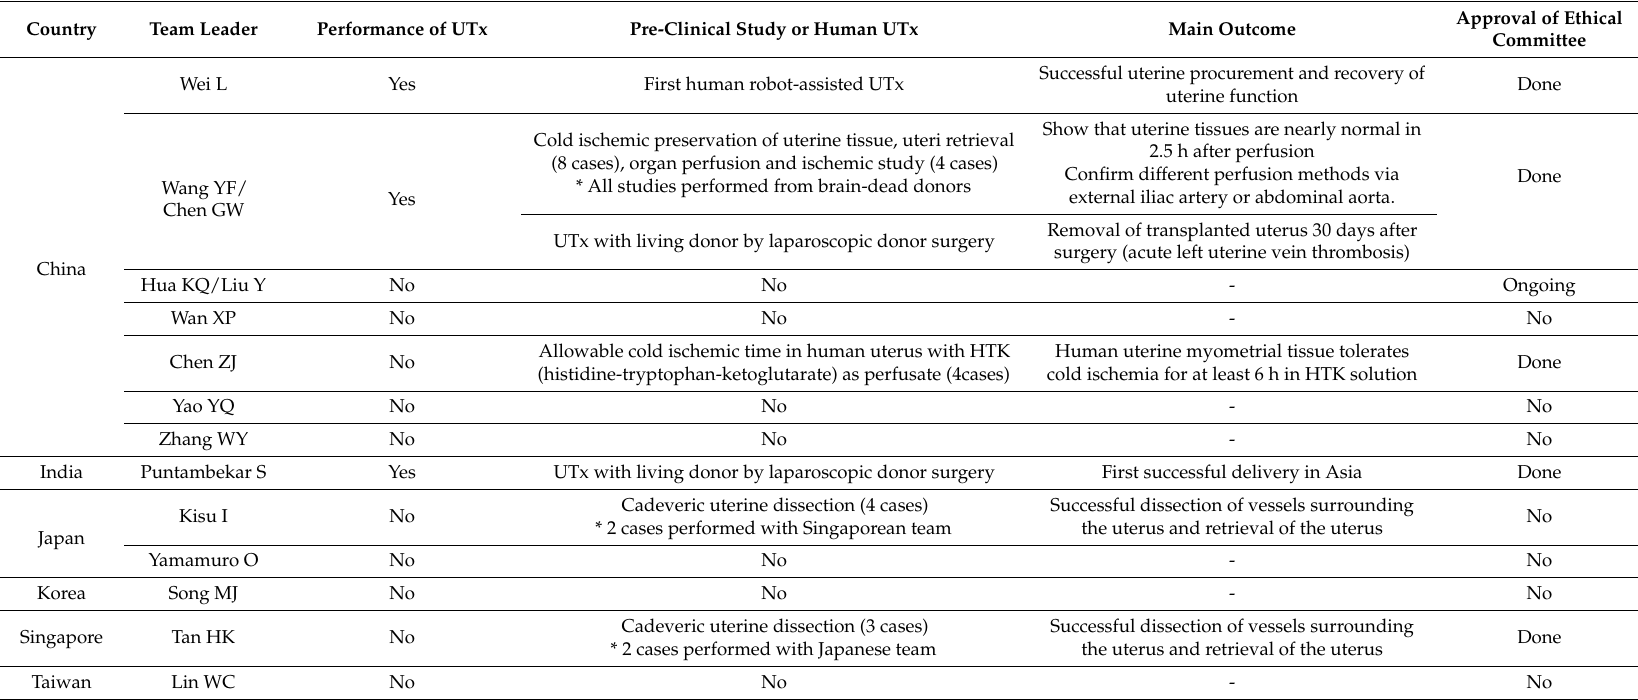
Table 3. Preclinical studies and human UTx research in